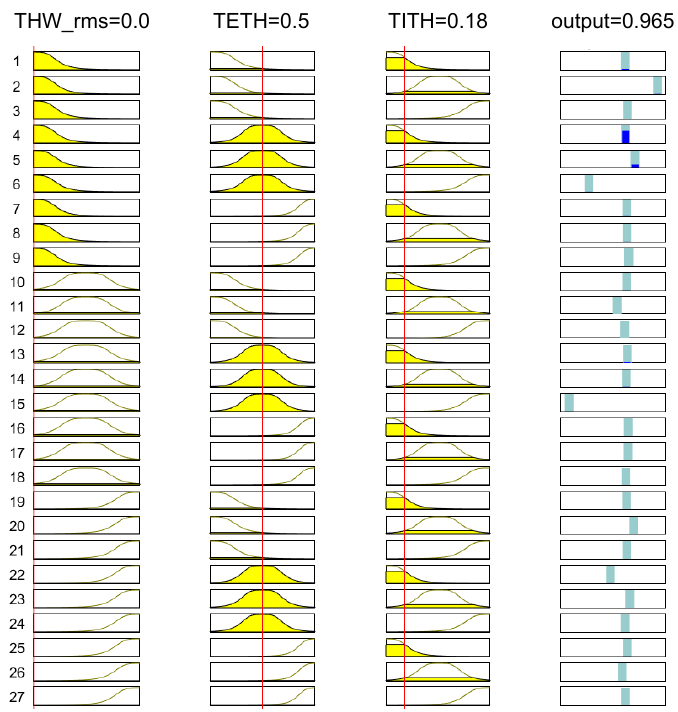
Figure 11. Rules and membership functions of ANFIS Cluster 1 for a given input.